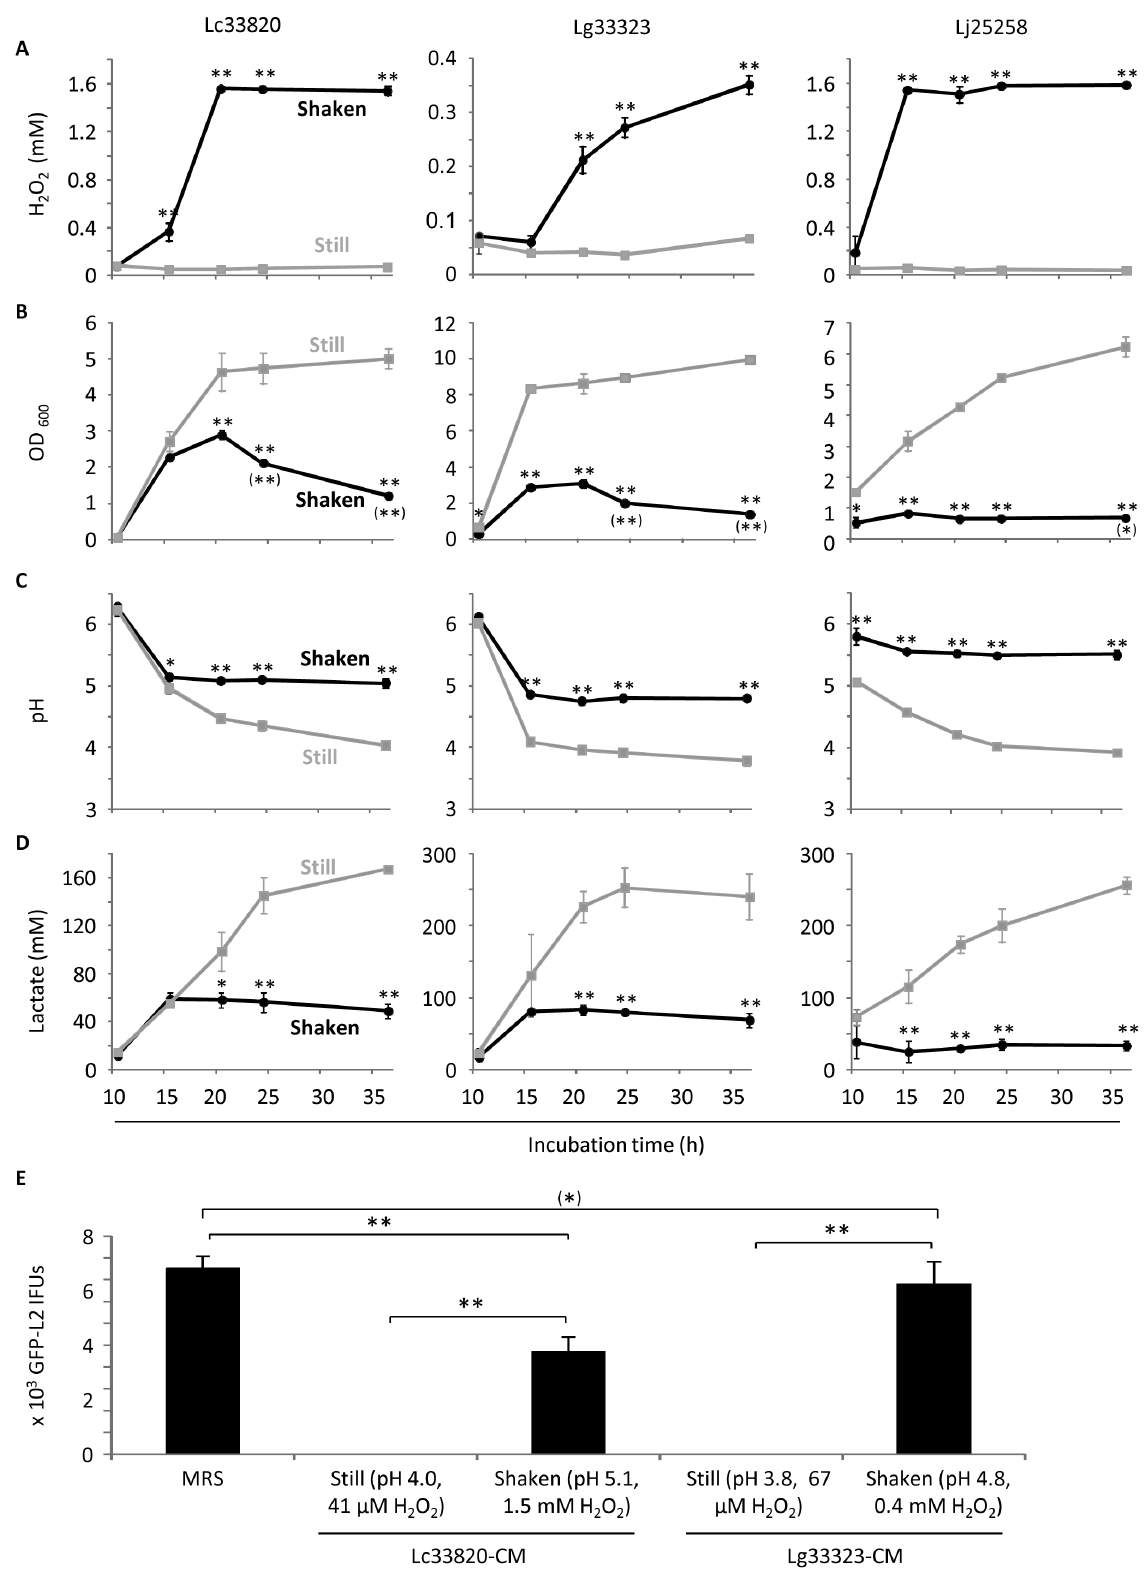
Figure 8. Induction of H 2 O 2 production coupled with decreased lactic acid production and loss of chlamydiacidal activity. Overnight Lactobacillus cultures were diluted with fresh MRS to 0.02 OD 600 . The diluted bacterial suspensions were incubated as still cultures or shaken cultures as described in ‘‘Materials and Methods’’. At indicated times, samples were taken for determination of the concentrations of H 2 O 2 (A) and bacteria (B), pH values (C), lactic acid concentrations (D) and anti-chlamydial activities (E). Values were averages 6 standard deviations of triplicate experiments.